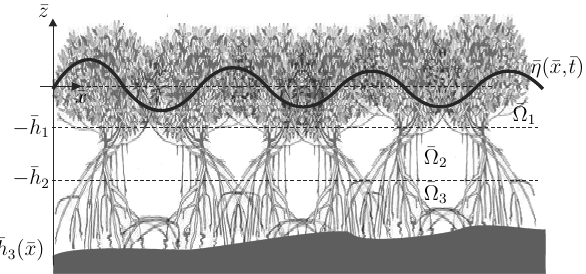
Fig. 1. Schematic diagram of the emerged three-layer porous domain.